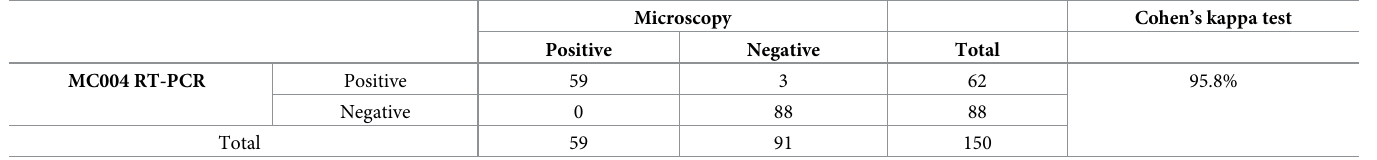
Table 2. Agreement between microscopy and MC004 RT-PCR for mono parasite